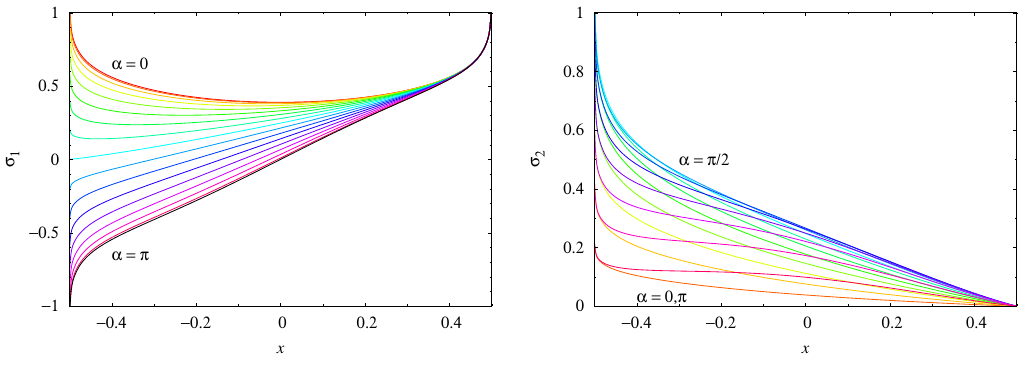
Figure 11. The same as (cid:12)gure 2 but for L = 1.